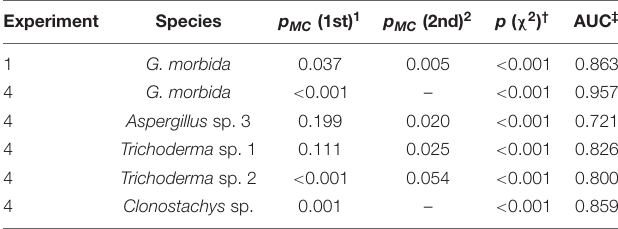
TABLE 1 | Model statistics for logistic regression of survival of fungi on final wood moisture content (MC). Experiment Species